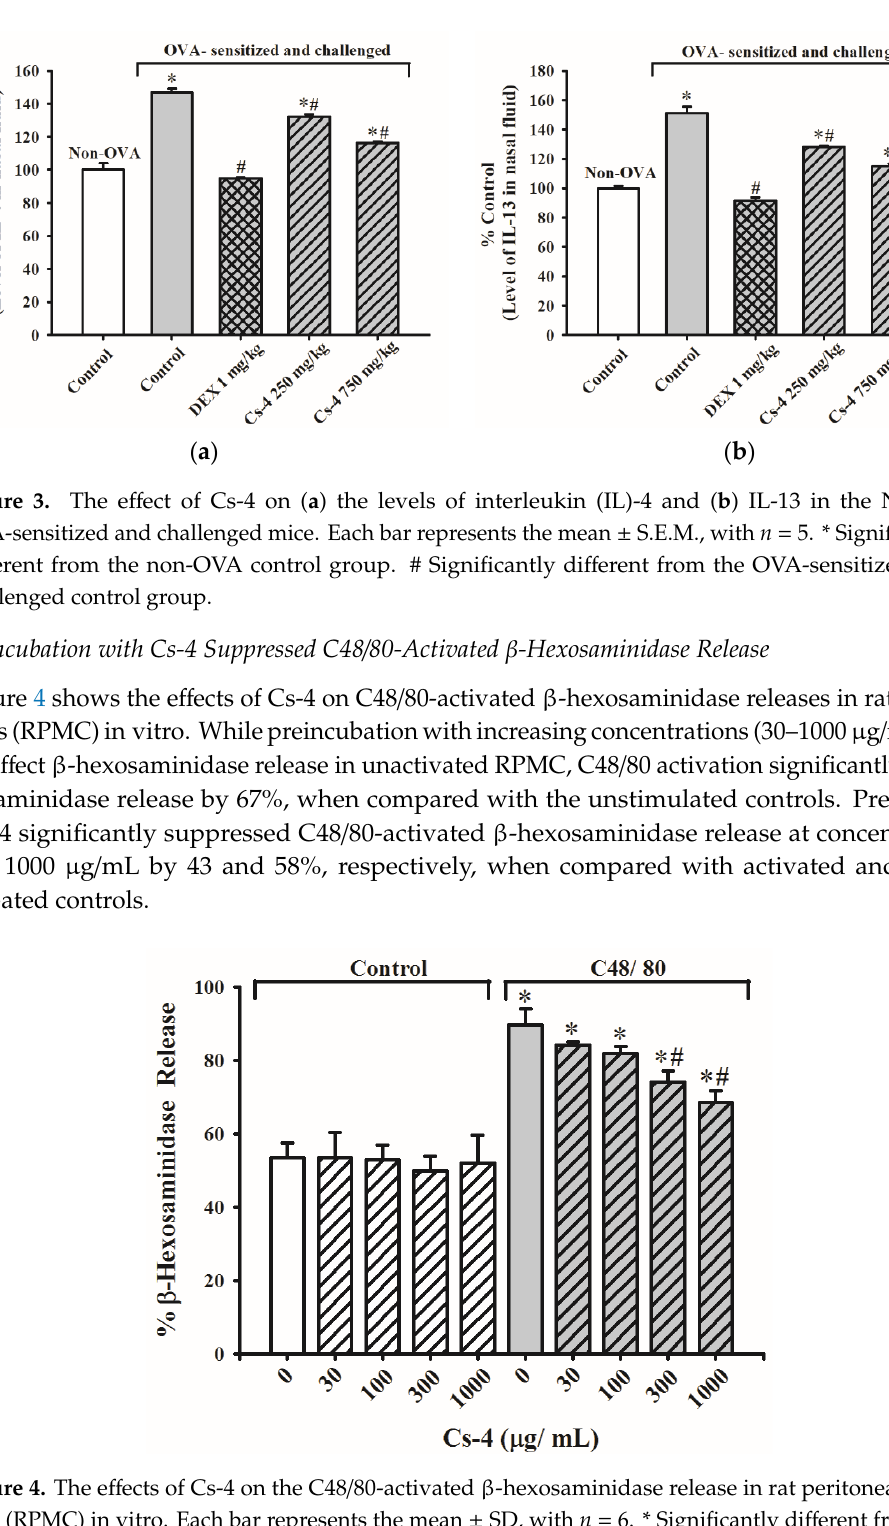
Figure 4. The effects of Cs-4 on the C48/80-activated β-hexosaminidase release in rat peritoneal mast cells (RPMC) in vitro. Each bar represents the mean ± SD, with n = 6. * Significantly different from the control group. # Significantly different from the C48/80 non-Cs-4-incubated control group.